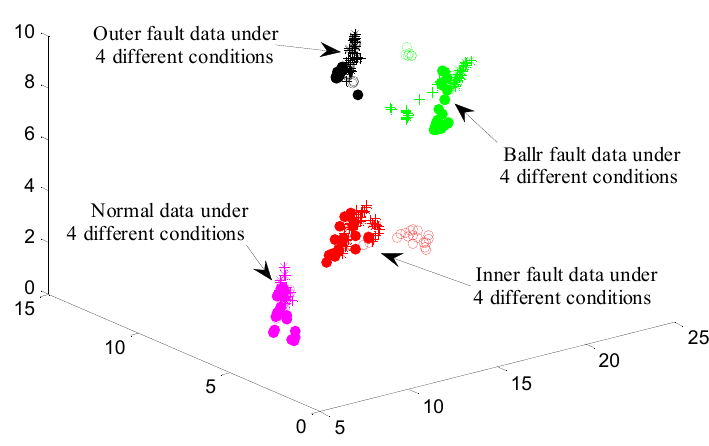
Figure 18. The feature scatter diagram in three-dimensional space.